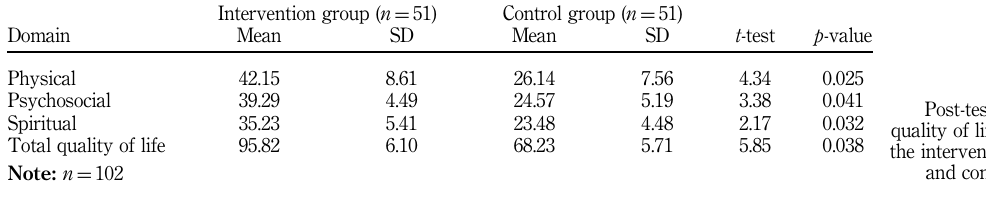
Table II. Post-test scores of